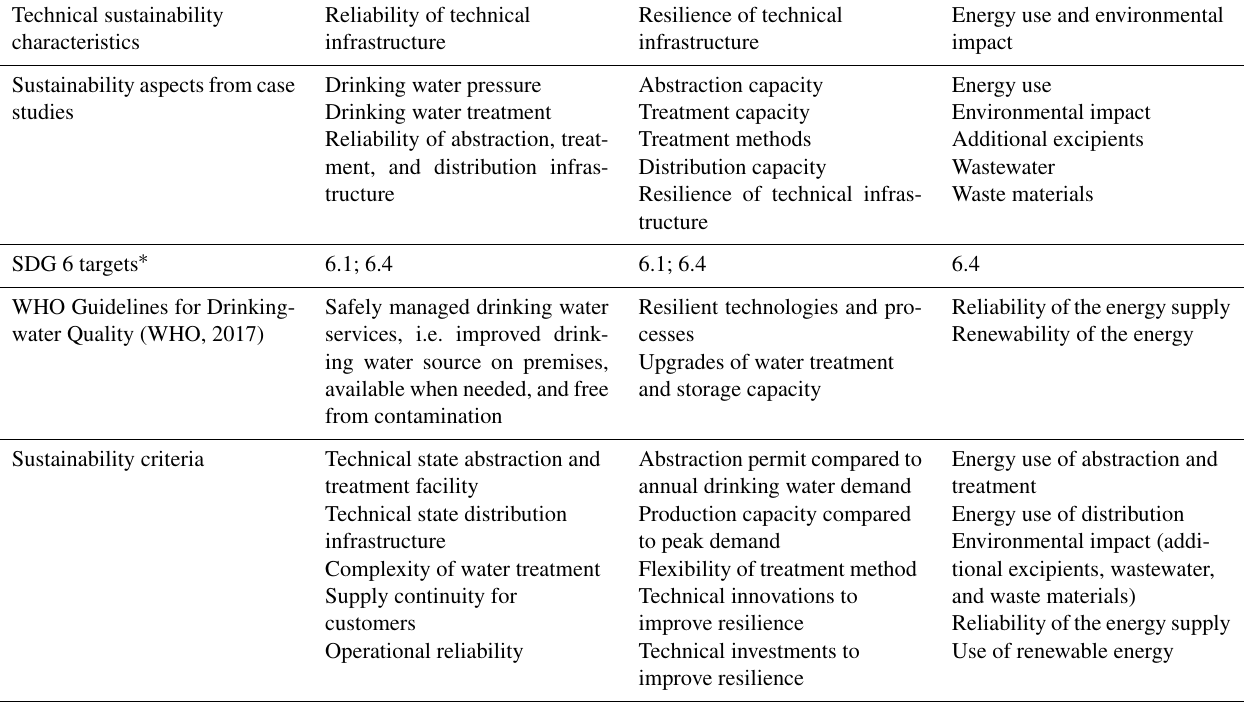
Table 2. Summary of proposed technical sustainability characteristics, technical aspects from case studies (see Appendices A–C),